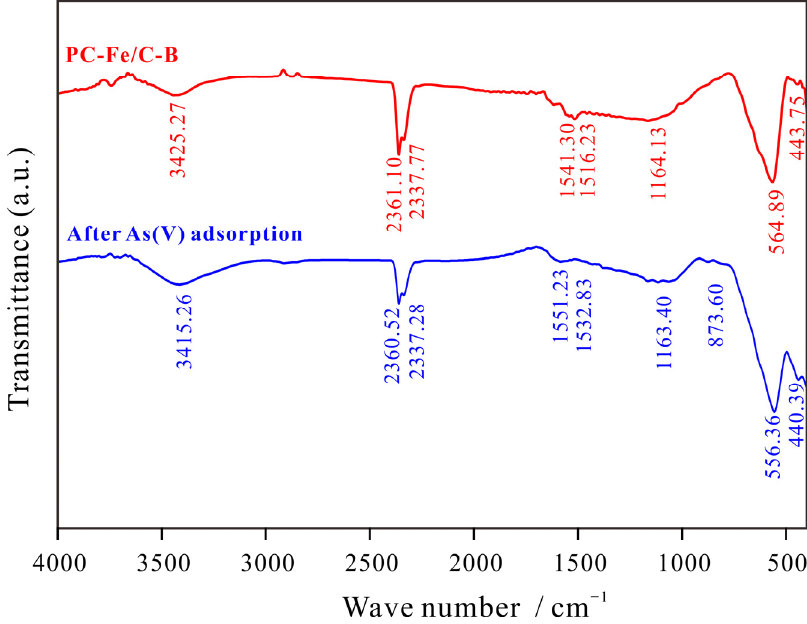
Figure 3. FT ‐ IR patterns of PC ‐ Fe/C ‐ B, before and after As(V) adsorption. The XPS survey spectra and high ‐ resolution Fe 2p, C 1s, and O 1s spectra of PC ‐ Fe/C ‐ B, after As(V) adsorption, are shown in Figure 4. After As(V) adsorption, the As 3d peak, with a binding energy of 42.78 eV, was detected, which indicated that As existed as As(V) without a redox reaction [36]. The O 1s and Fe 2p peaks, after As(V) adsorption by PC ‐ Fe/C ‐ B, showed almost no shift, indicating that the chemical states of O and Fe did not change after As(V) adsorption. The atomic percentages of PC ‐ Fe/C ‐ B, after As adsorption, were 58.96% C, 28.72% O, 11.07% Fe, and 1.25% As. Moreover, since the charge amount of the above electron transfer was far less than a unit of electricity, it was speculated that the transfer of the outer shared electron pair occurred during the bonding process.